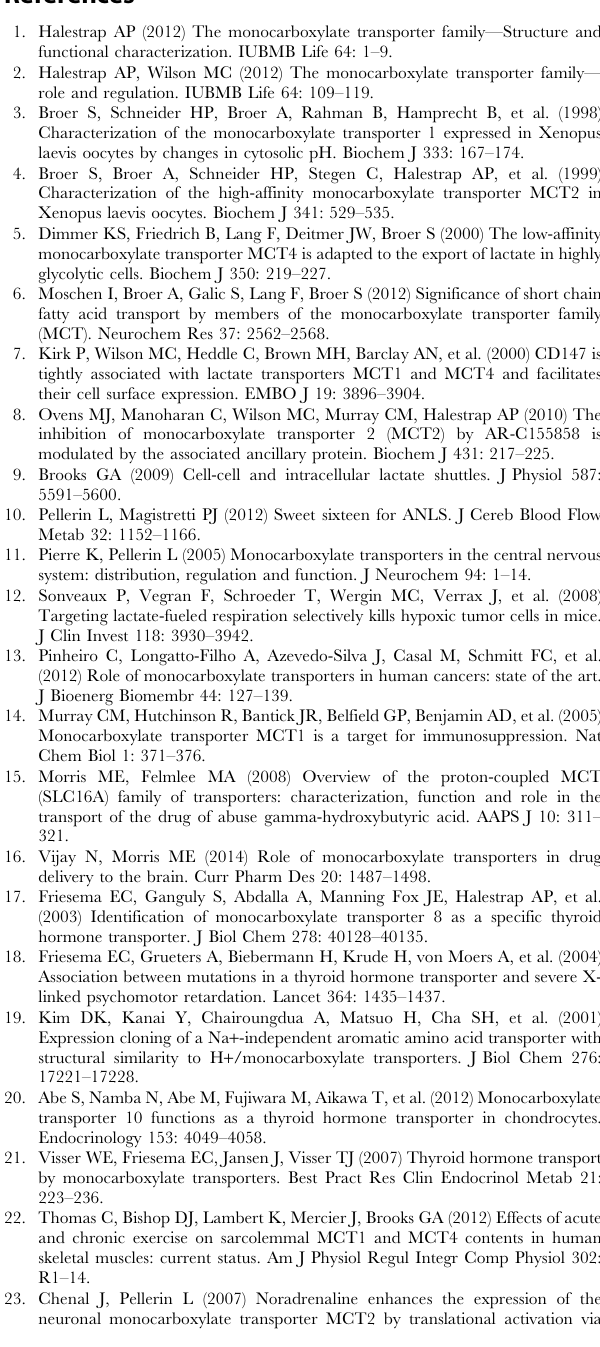
Figure S2 Relative mRNA concentration of (A) CD147 and (B) embigin in mouse tissues in response to fasting and PPAR a . Values represent means 6 SD of relative mRNA concentrations of wildtype (WT) and PPAR a knockout (KO) mice that were fed ad libitum or fasted for 48 h (n= 16). Data were analyzed by two-way ANOVA. Classification factors were genotype, fasting, and the interaction between both factors. P -values revealed by two-way ANOVA are noted above the figures. Individual means of the treatment groups were compared by Tukey’s test in case of variance homogeneity. In case of variance heterogeneity, as revealed by Levene’s test, individual means were compared by